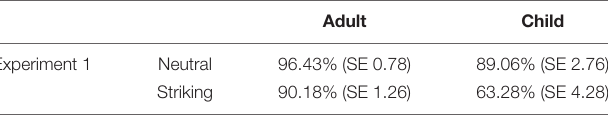
TABLE 2 | Mean percentage of property extension across conditions in Experiment